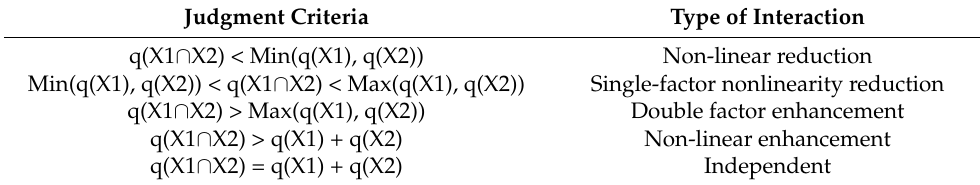
Table 4. Type of